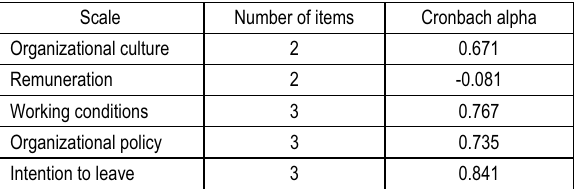
Table 1. Reliability of